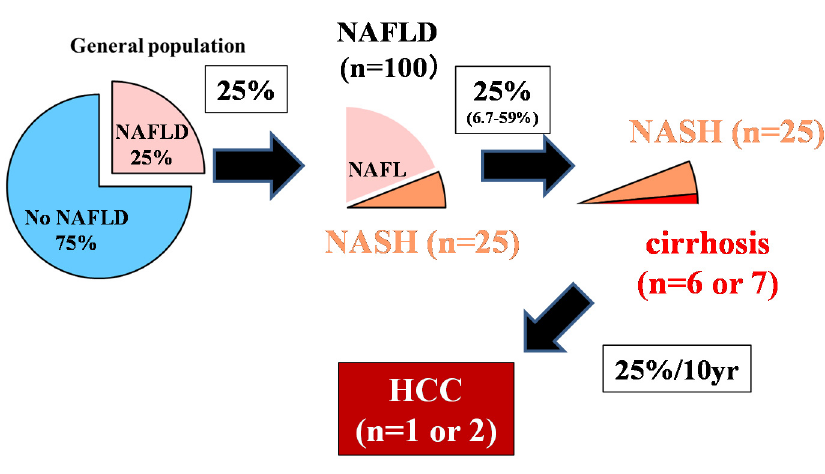
Figure 1. The 25% rule in nonalcoholic fatty liver disease (NAFLD) [10].